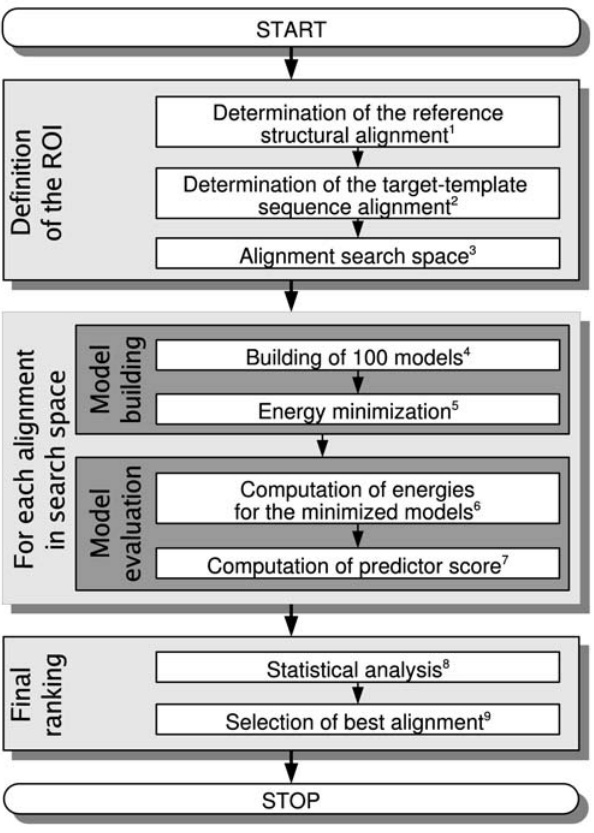
Figure 1. Flowchart of the method. A reference structural alignment of the target and the template is generated by the MALIGN3D command in MODELLER [11] (step 1). The initial target- template sequence alignment is realized by T_COFFEE (step 2). The regions of interest (ROI), defined as misaligned secondary structure elements together with their adjacent loops, are identified by comparison of the initial target-template sequence alignment with the reference structural alignment. A set of alignments to evaluate is generated using an exhaustive ungapped search in the ROI (step 3). Hundred models for each alignment are built using MODELLER (step 4). For each model, an energy minimization is done in vacuum using CHARMM (step 5). The energy for the minimized models is calculated (step 6). The secondary structure is assigned with DSSP [24] and the predictor’s scores are calculated (step 7). After all alignments are processed, a statistical analysis using the statistical package R (http:// www.R-project.org) is further performed on the predictor to associate a degree of confidence to the prediction (step 8) and the best alignment is determined (step 9). See Materials and Methods for